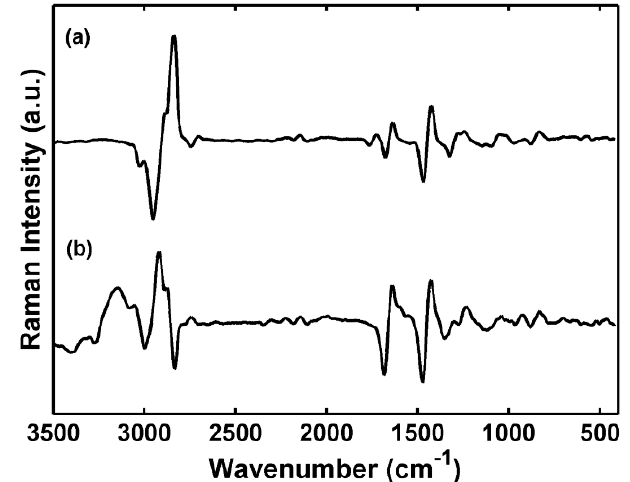
Figure 3. Plot of the loadings of ( a ) PC1, ( b ) PC2 versus wavenumber (variables) for the PCA